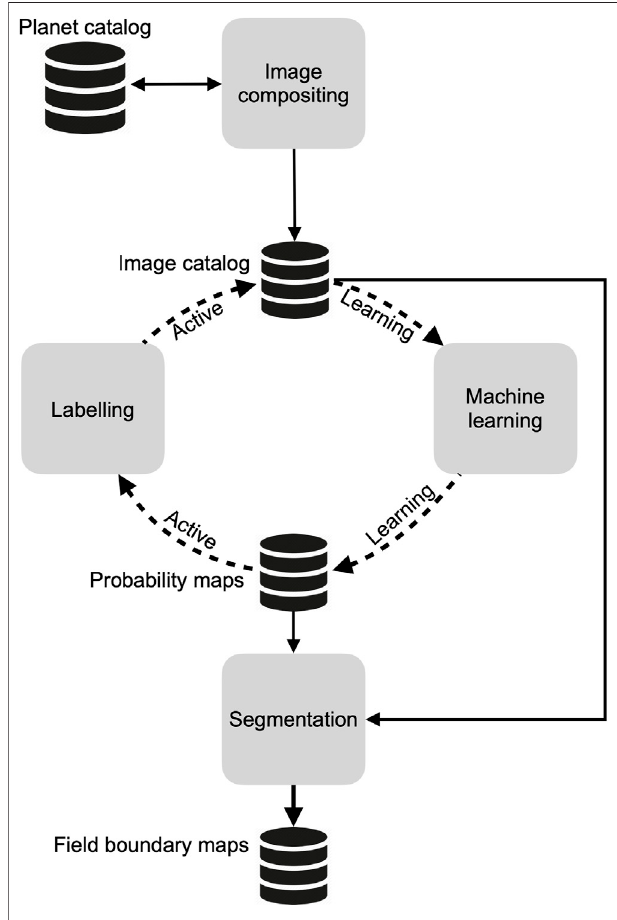
FIGURE 1 | An overview of the primary mapping components, the data stores that hold the inputs and outputs from each component, and the direction of connections between them. The dashed line indicates iterative interactions, while solid lines indicate one-time or irregular